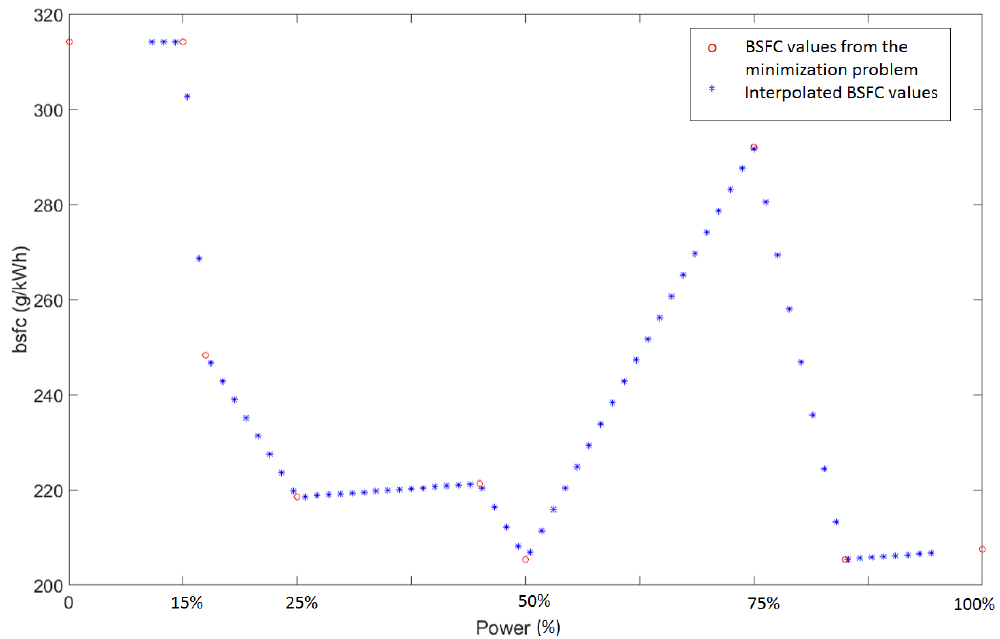
Figure 6. Exemplary of bsfc interpolation over the power range.